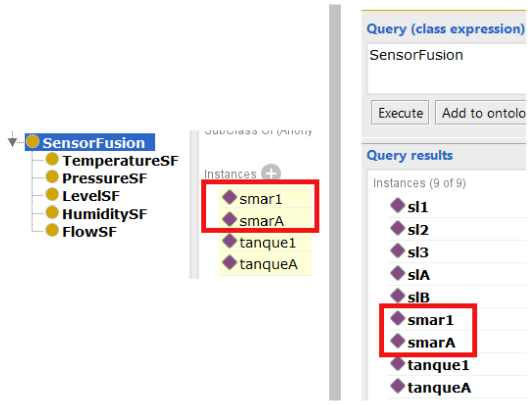
Figure 13. The left side shows the elements and, with a red square, the production lines with fusion. The right side shows the DL Query with all elements that are in fusion, including the production lines.